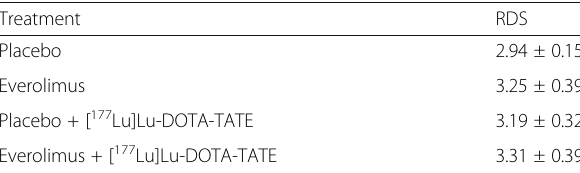
Table 5 Renal damage score (RDS) expressed as means and 95% confidence interval